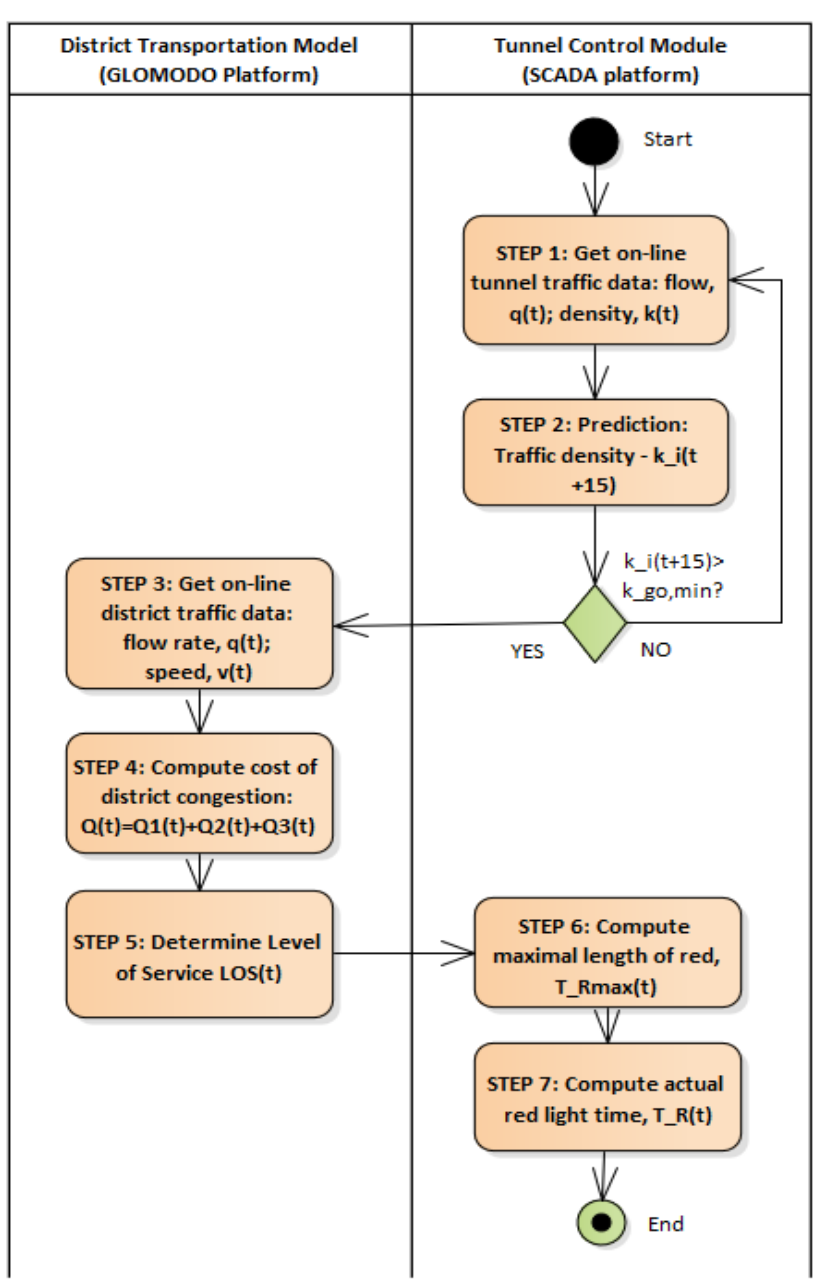
Figure 12. Flow chart for the proposed new road urban tunnel traffic control algorithm.